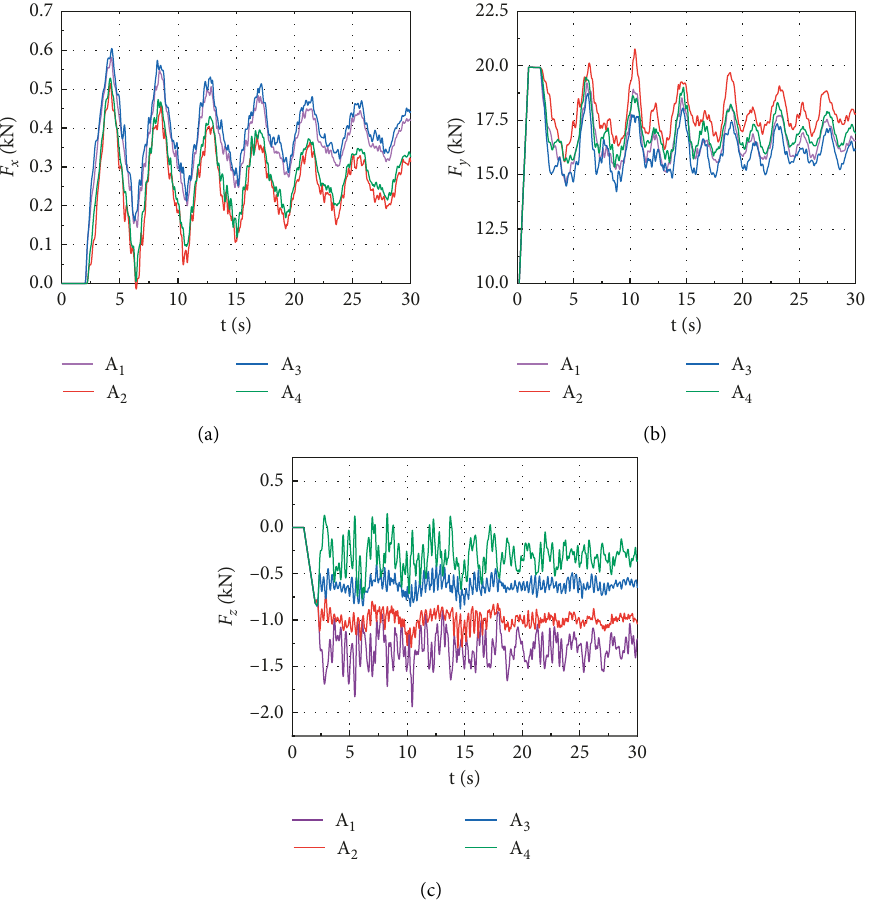
Figure 23: Conductor tension applied on suspension string: (a) Fx , (b) Fy, (c) Fz .